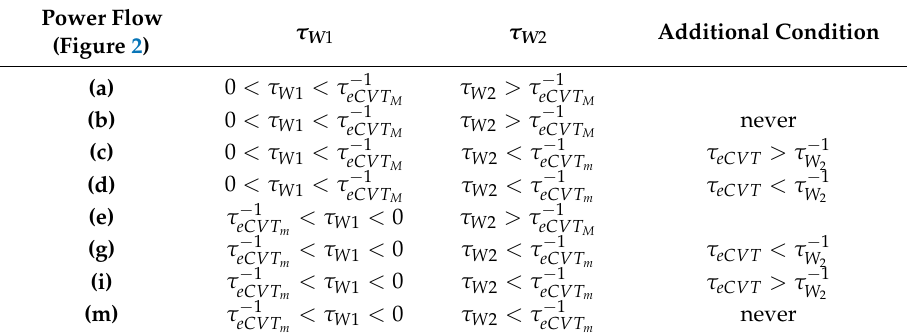
Table 10. Case 4—Power flows for each range of the planetary gear constants for τ eCVT < 0 . Power Flow